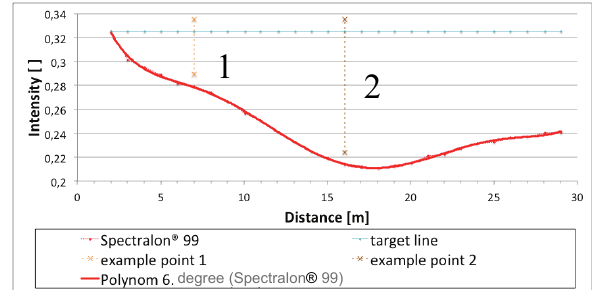
Figure 10. Concept of the intensity correction (Riegl)